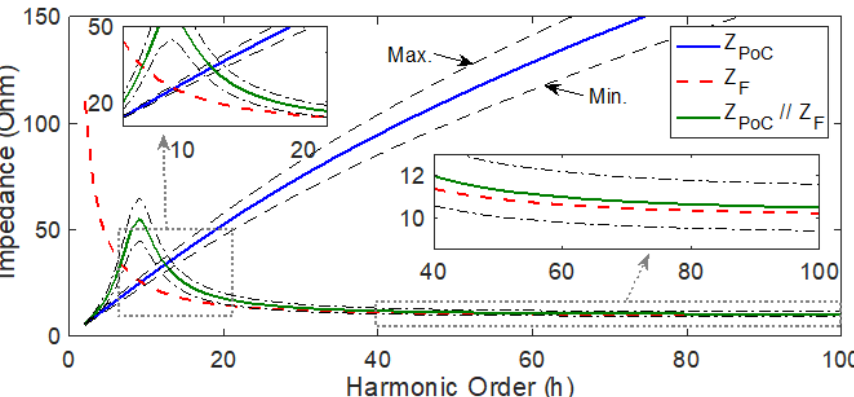
Figure 11. System harmonic impedances variations performed using the developed MCS-based